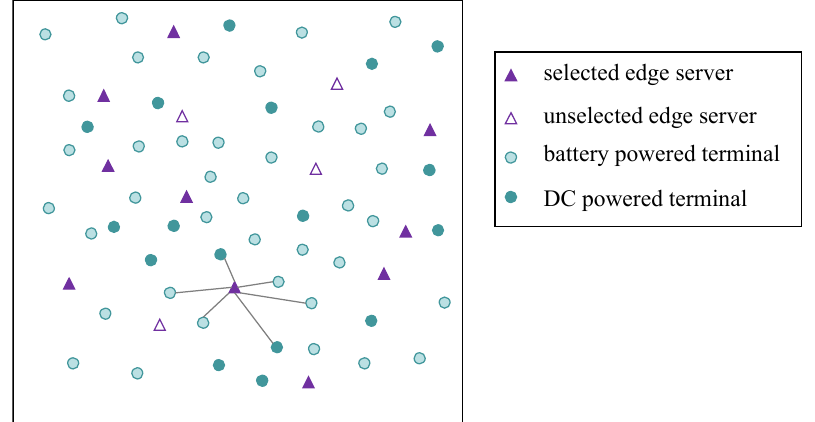
Figure 2. Terminal and edge node distribution diagram.